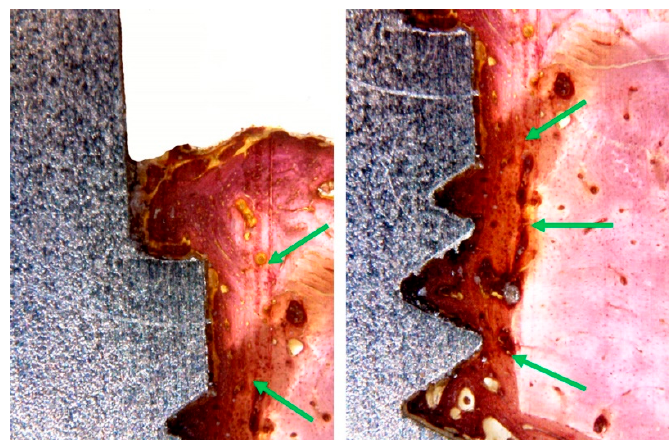
Figure 8. Histological images of the TiT group shows the bone to implant contact and a great quantity of bone matrix formation (red staining) around the surface (green arrows).